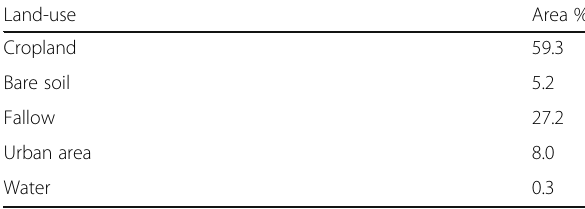
Table 2 Land-use distribution at the catchment area Land-use